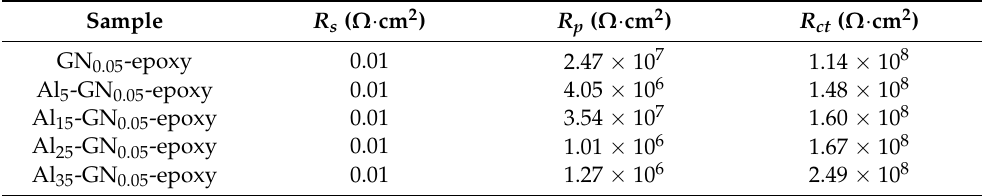
Figure 14. Nyquist plots of EIS for coatings filled with 0.05 wt.% of GN1100 and various contents (5, 15, 25 and 35 wt.%) of Al immersed in 3.5 wt.% NaCl solution.